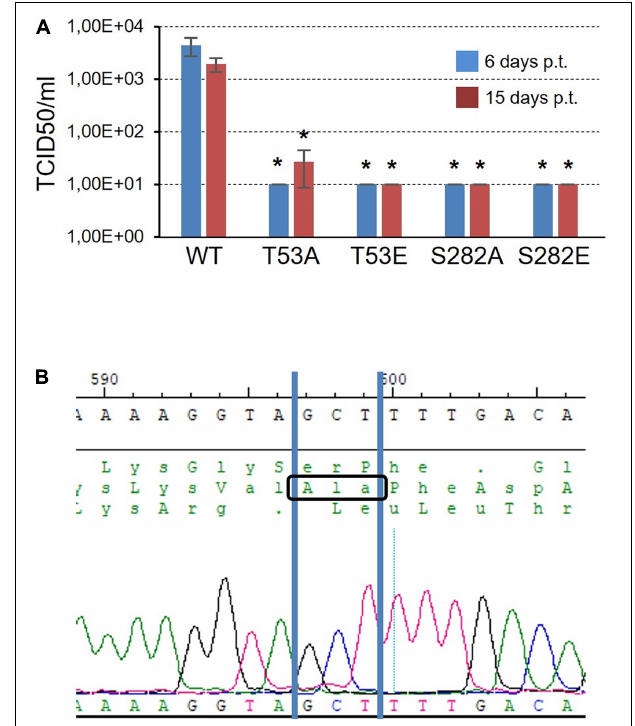
FIGURE 7 | Infectivity of T53 and S282 mutants. (A) TCID50/ml values obtained 6 and 15 days post-transfection (blue and red bars, respectively) after transfecting Huh7.5 cells with RNA corresponding to WT virus and the T53A, T53E, S282A, and S282E mutants. The threshold value was established at 10 TCID50/ml. Statistically significant differences (Student’s t -test) are represented as follows: * p < 0.05. Asterisk over the bar indicate the p -value comparing to WT. (B) Chromatogram showing the sequence obtained from the RNA of the T53A mutant rescued 15 days post-transfection. The GCT codon corresponding to the amino acid Ala is